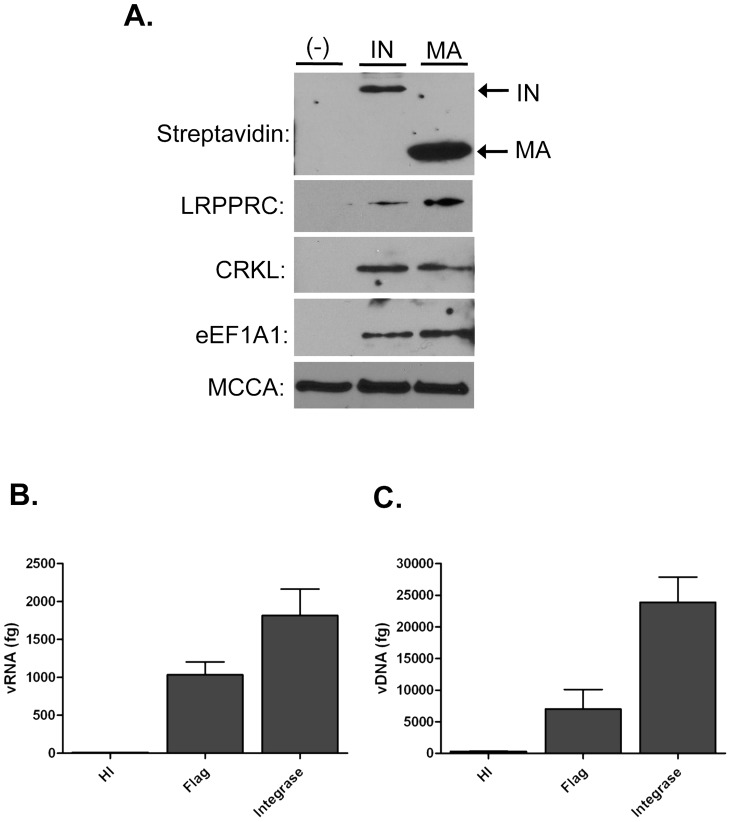
LRPPRC is present in affinity purified samples and associates with HIV-1 RNA and DNA complexes during early infection.(A) Western Blot analysis of affinity purified samples. C8166 cells were infected with VSVg pseudotyped NLXINB or NLXMAB virus. An uninfected control was performed in parallel. Cells were lysed with IP buffer and protein complexes were affinity purified using SA-agarose. SA-agarose bound protein complexes were separated by SDS-PAGE and subjected to Western Blot with streptavidin-HRP and the indicated antibodies. (B) Immunoprecipitation RT-PCR in 4h infected cells. 293T cells were transfected with Flag-LRPPRC and infected with NLX. The cells were lysed, immunoprecipitated with the indicated antibodies, viral RNA isolated and quantified by real-time RT-PCR. The background level of viral RNA isolated from an isotype control immunoprecipitation was subtracted from each sample. (C) Immunoprecipitation PCR in 4h infected cells. Experiments were performed as in (B) except viral DNA was isolated and detected by real-time PCR. Data shown in both panels is representative of 3 replicates and error bars show SEM.